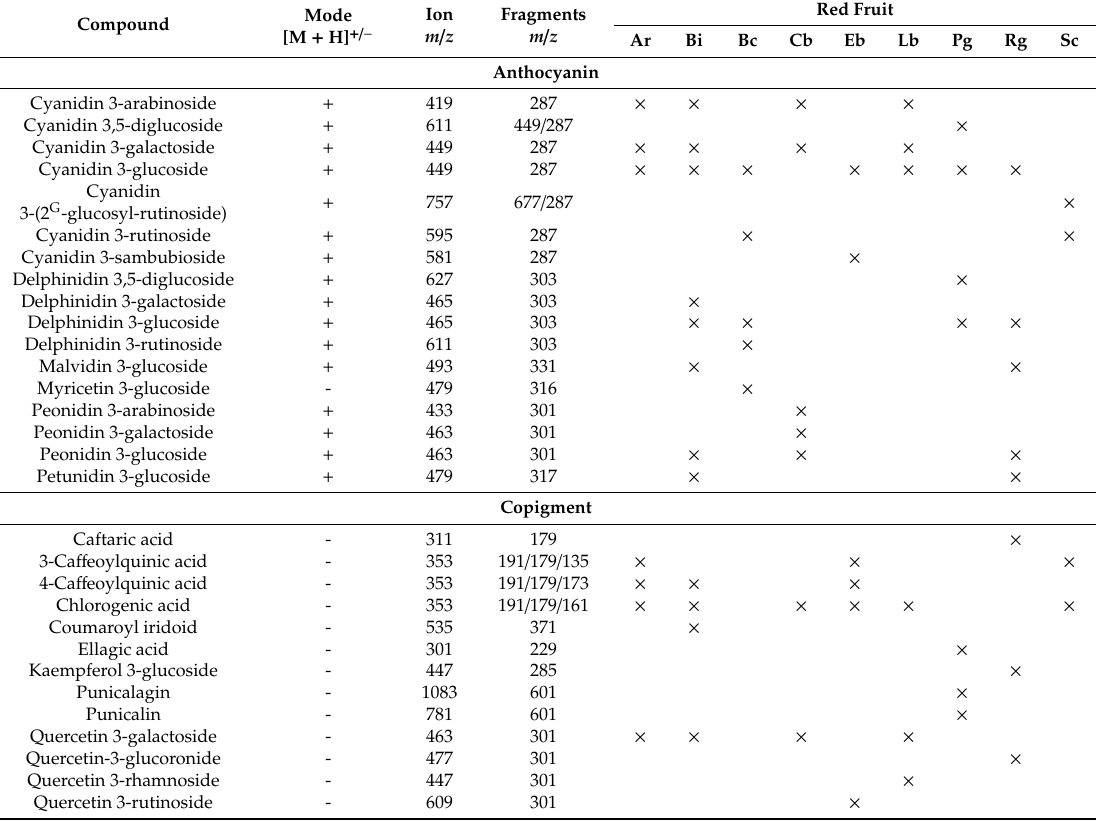
Ar = Aronia, Bi = Bilberry, Bc = Blackcurrant, Cb = Cranberry, Eb = Elderberry, Lb = Lingonberry, Pg = Pomegranate, Rg = Red grape, Sc = Sour cherry.